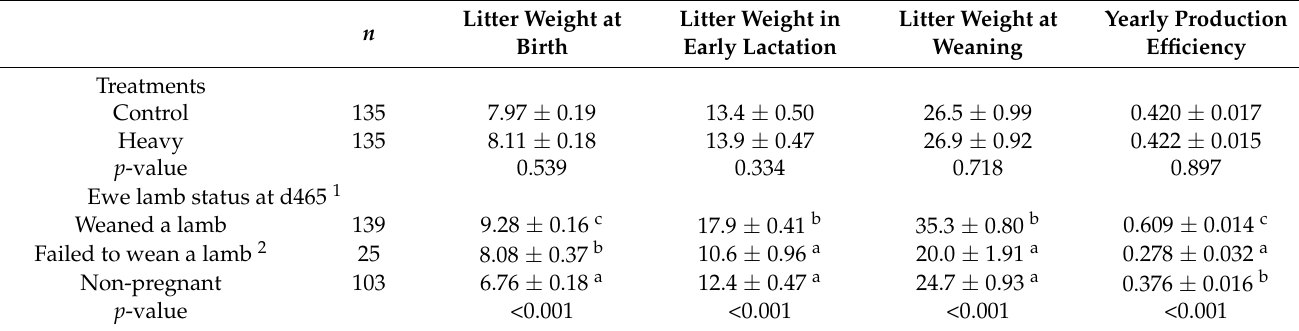
Table 3. The effect of treatment (control vs. heavy) and ewe lamb status at d465 1 (weaned a lamb, failed to wean a lamb, non-pregnant) on least-square means ( ± SEM) of the yearly litter weight (kg) at birth, early lactation, and weaning per ewe over the three-year period, and the yearly production efficiency (yearly litter weaning weight/ewe live weight at breeding) across their first three years of